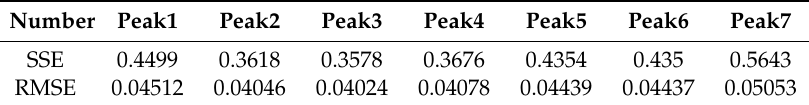
Table 1. The results of Gaussian